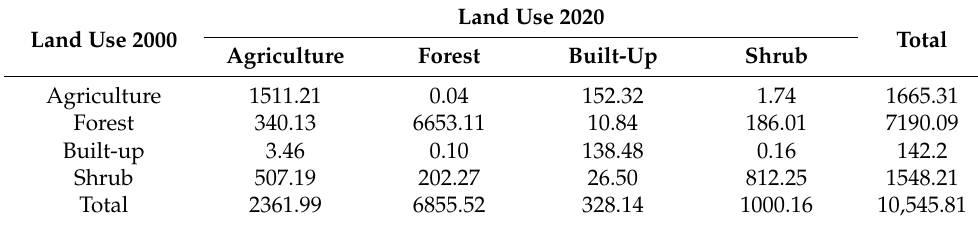
Table 1. Transition matrix (in km 2 ) of land use change between 2000 and 2020. Land Use